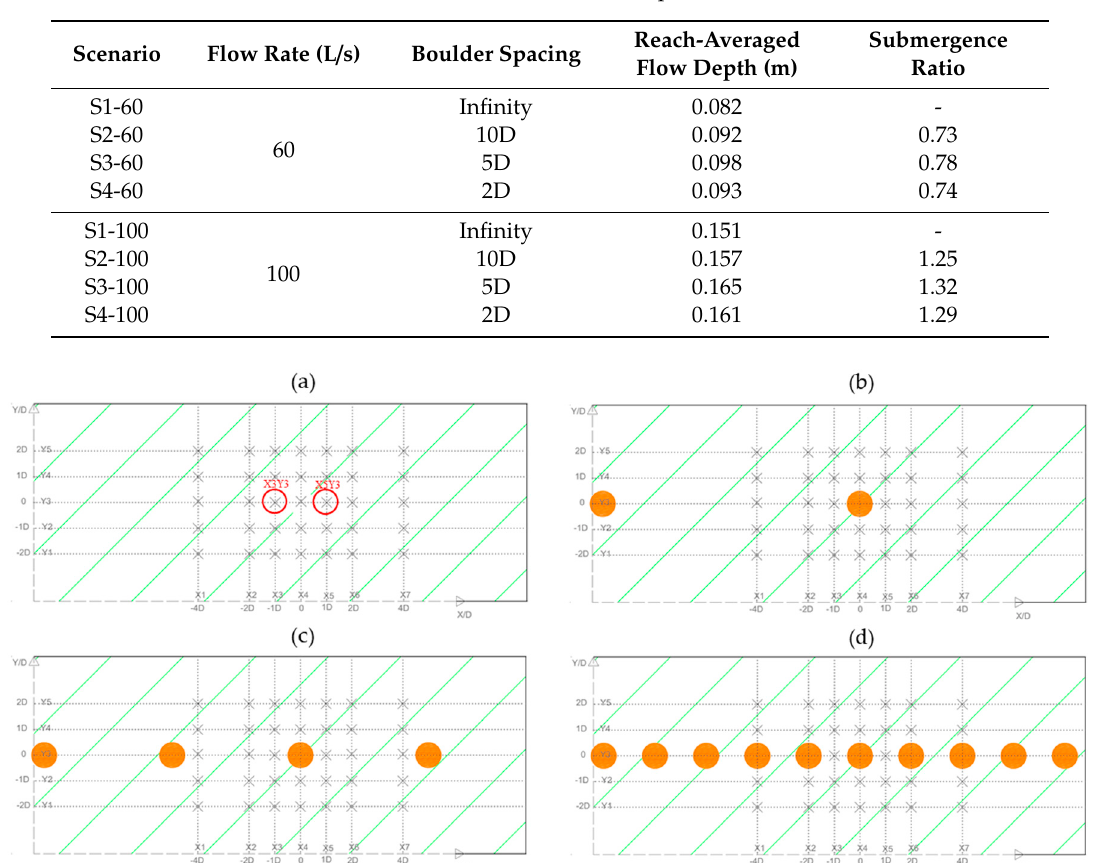
Figure 2. A schematic plan of boulder arrangement in the measurement zone (hatched area) for ( a ) no boulder, ( b ) 10D boulder spacing, ( c ) 5D boulder spacing, and ( d ) 2D boulder spacing. Cross marks show measurement points for each setup, and large circles show the position of idealized (assumed fully spherical) boulders. Two points X3Y3 and X5Y3 have been marked in ( a ) as common measurement points in the centerline of boulders in all scenarios. Table 1. Characteristics of the experiments.